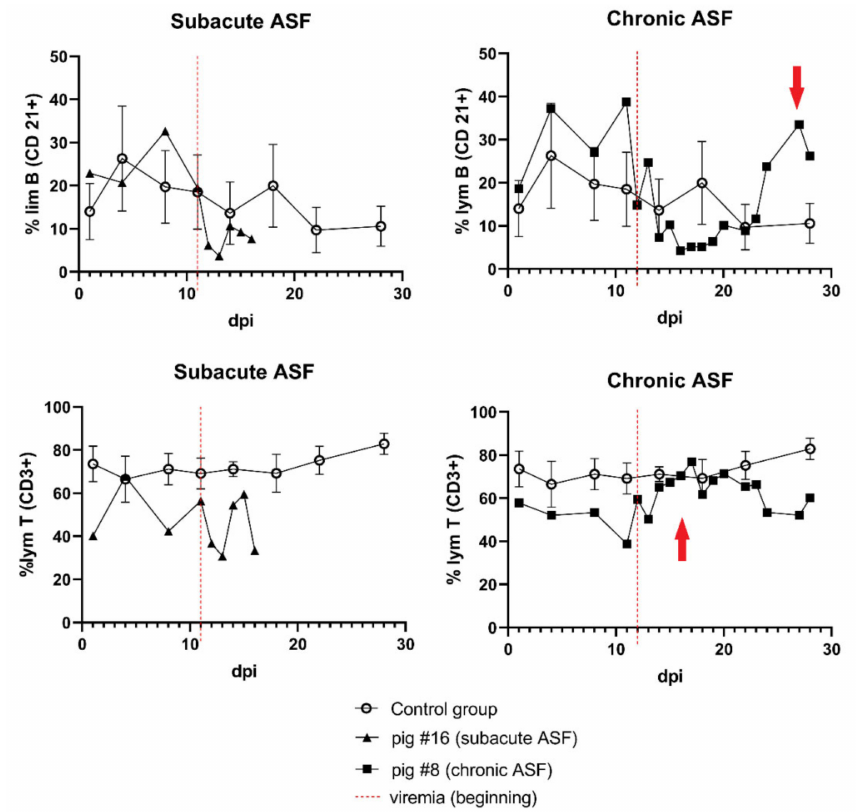
Figure 7. The percentages of the T (CD3+) and B (CD21+) lymphocyte population in pig #8 presenting the chronic ASF form (survivor) in comparison to pig #16 presenting the subacute ASF. The red arrows indicate an increase in both lymphocyte populations. Error bars indicate standard